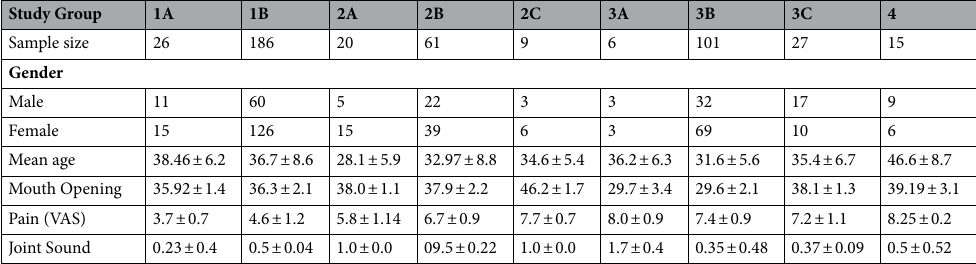
Table 2. Demographic features and baseline values in outcome variables within each of study group.